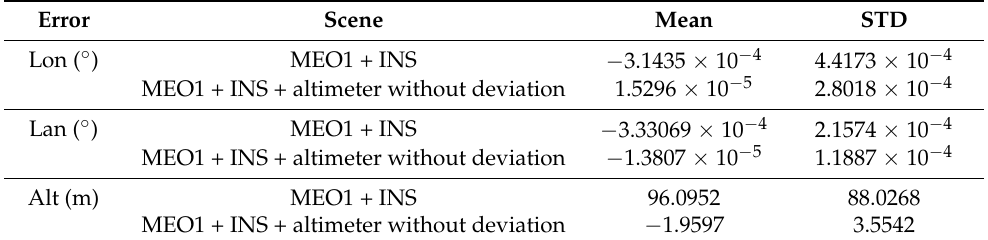
Table 10. Trajectory error